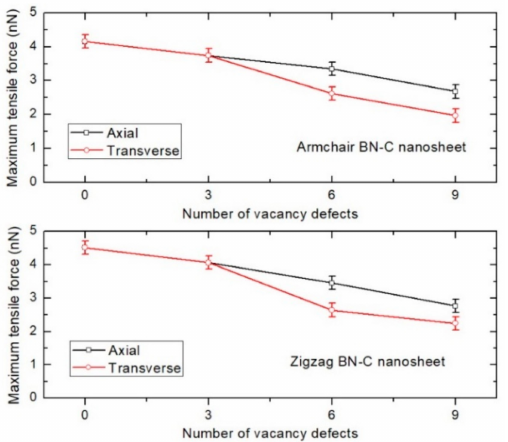
Figure 9. Plot of the maximum tensile force of BN–C / PE nanocomposites with varying vacancy defect concentrations at 300